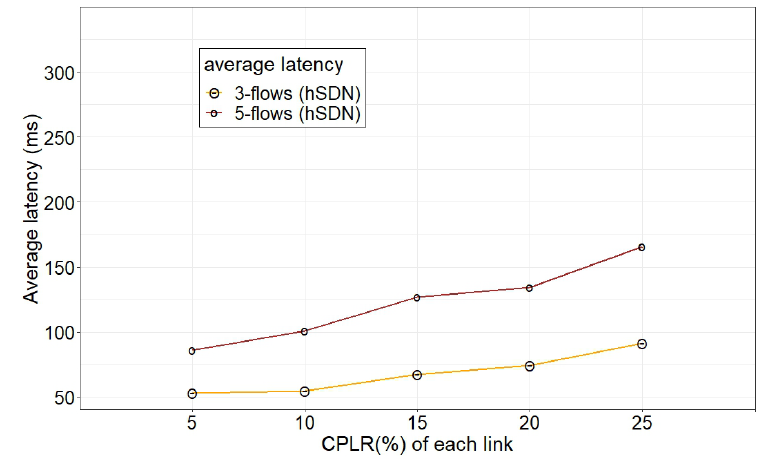
Figure 19. Data plane performance (average latency) of hSDN during data plane link failures for various times under unreliable control plane conditions in a 16-node grid network.